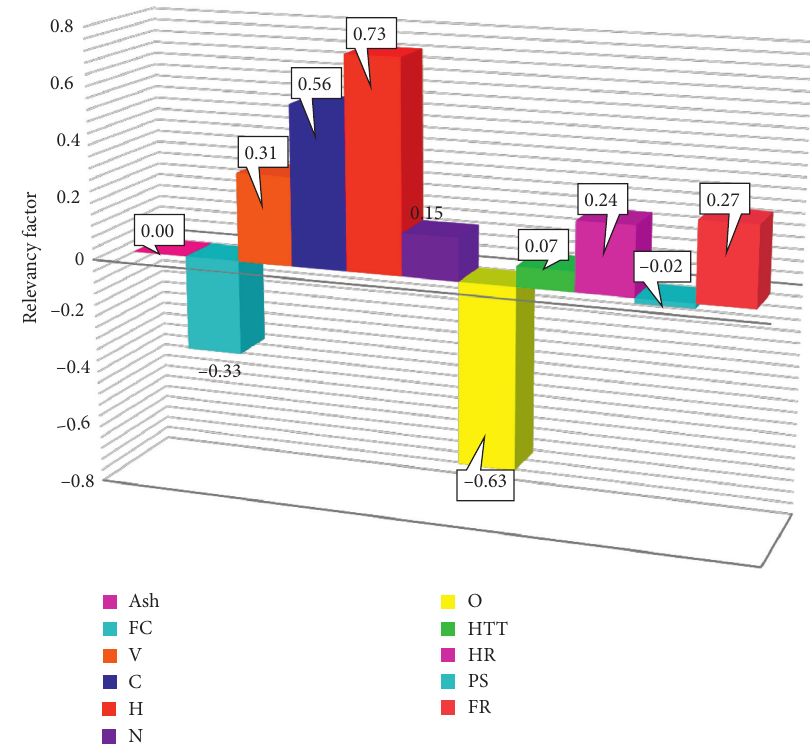
Figure 2: Sensitivity analysis on input data to determine the extent of their impact on the output parameter.